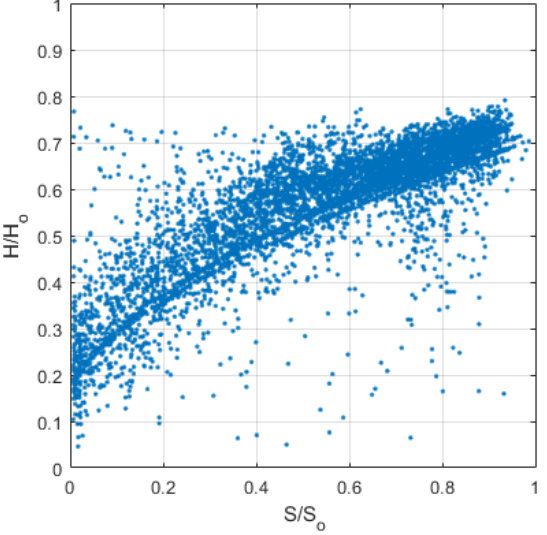
Figure 3. Variation of measured solar radiation and sunshine hours of the day at BARCELONA/AIRPORT station (S04) for the period 2000 to 2018.